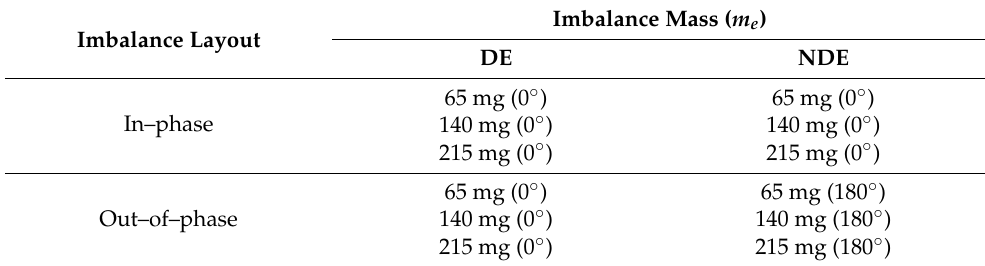
Table A1. Imbalance mass parameters of the test